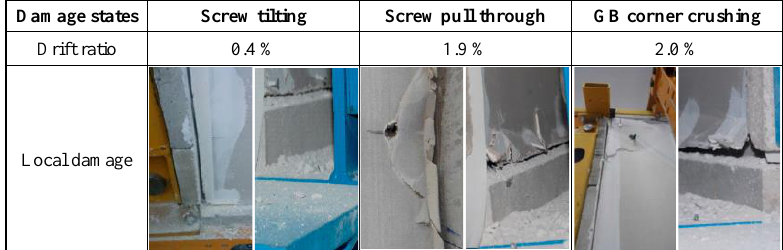
Figure 18. Damage-to-drift ratio relation of the reference specimens (from Pali et al. [34], Fiorino et al. [35].